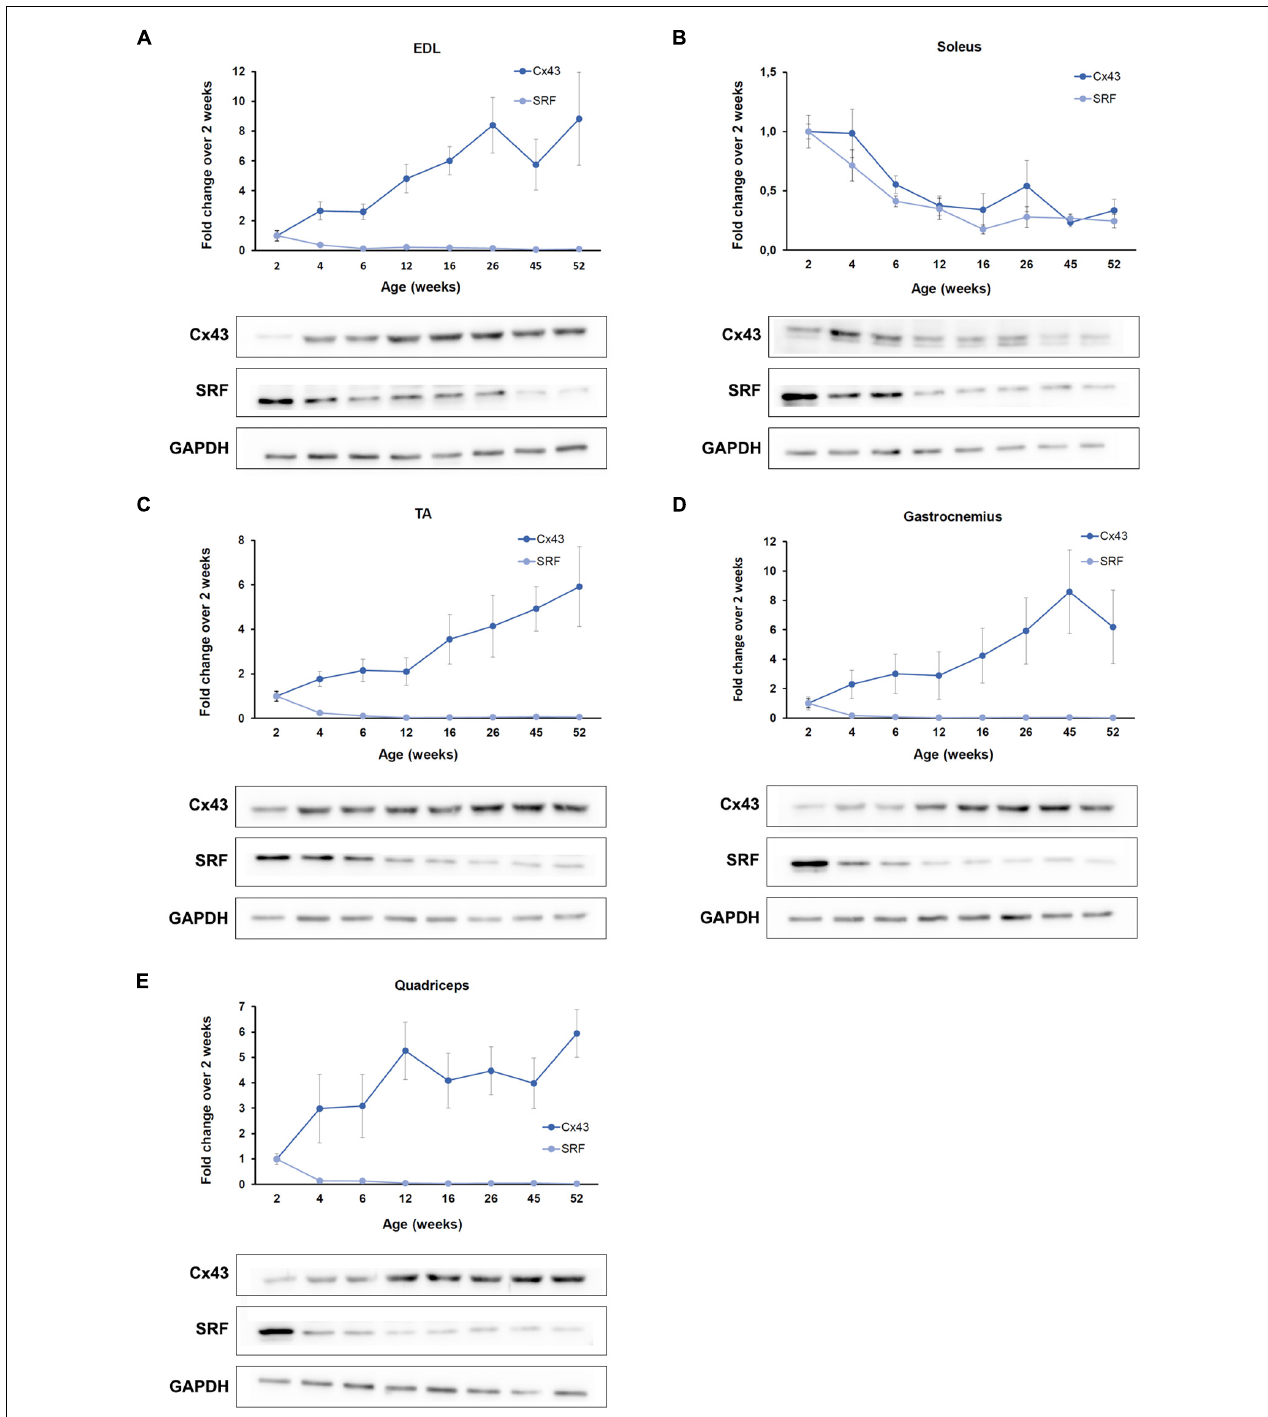
FIGURE 4 | SRF and Cx43 production is inversely associated to the myomiR expression. The function of the four myomiRs in the five skeletal muscles was further explored by evaluating the production levels of two of their established targets, SRF and Cx43. (A–E) Fold change (FC) levels obtained from western blot analysis of SRF and Cx43 across different ages and compared the 2-week levels are shown. SRF was determined to be inversely correlated to the endogenous expression of miR-1, miR-133a, and miR-133b for all five skeletal muscles. Cx43 was found to be inversely correlated to the endogenous expression profile of miR-206. The glycolytic muscles (A) EDL, (C) TA, (D) gastrocnemius, and (E) quadriceps were shown to express increasing levels of Cx43 as the mice age, while (B) the oxidative soleus muscle was identified to express decreasing Cx43 levels with muscle development. Representative western blot images are shown for each skeletal muscle. GAPDH was served as normalization control in three western blot analyses ( n = 3). Data on graphs represent the mean values ± SEM.